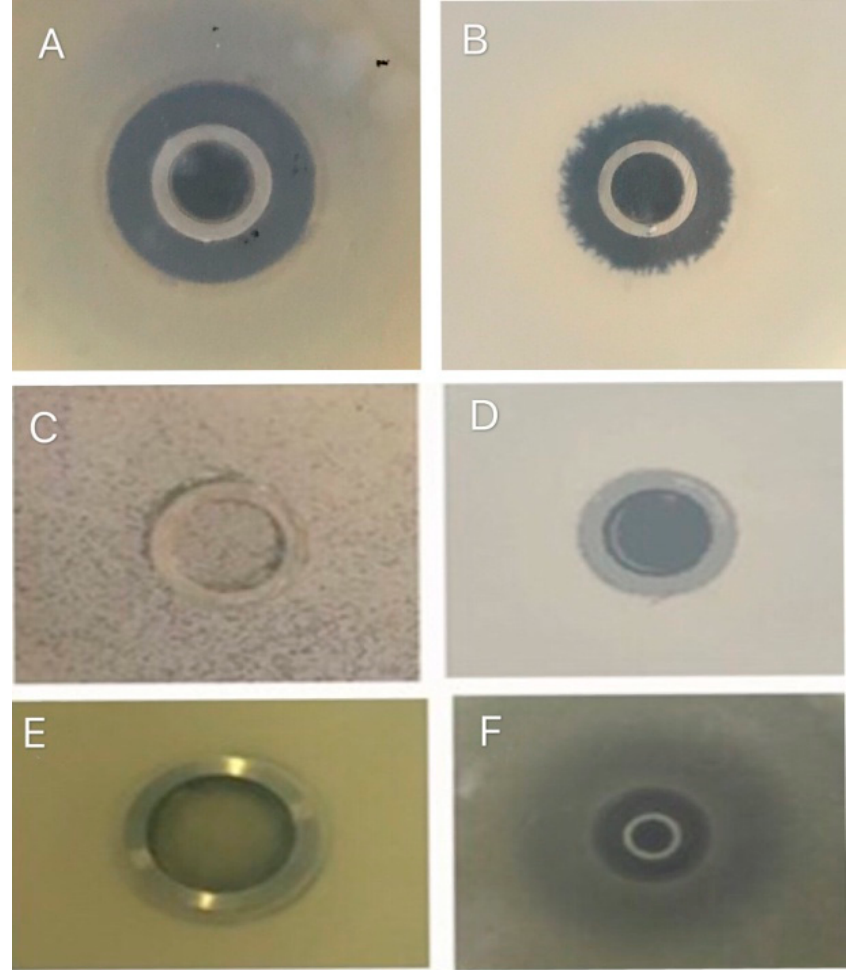
Figure 2. Inhibition zone of pathogenic bacteria, ( A ) Staphylococcus aureus , ( B ) Escherichia coli , ( C ) Yeast, ( D ) Salmonella typhimurium ( E ) Water, and ( F ) Kanamycin. ( D ) Salmonella typhimurium ( E ) Water, and ( F )